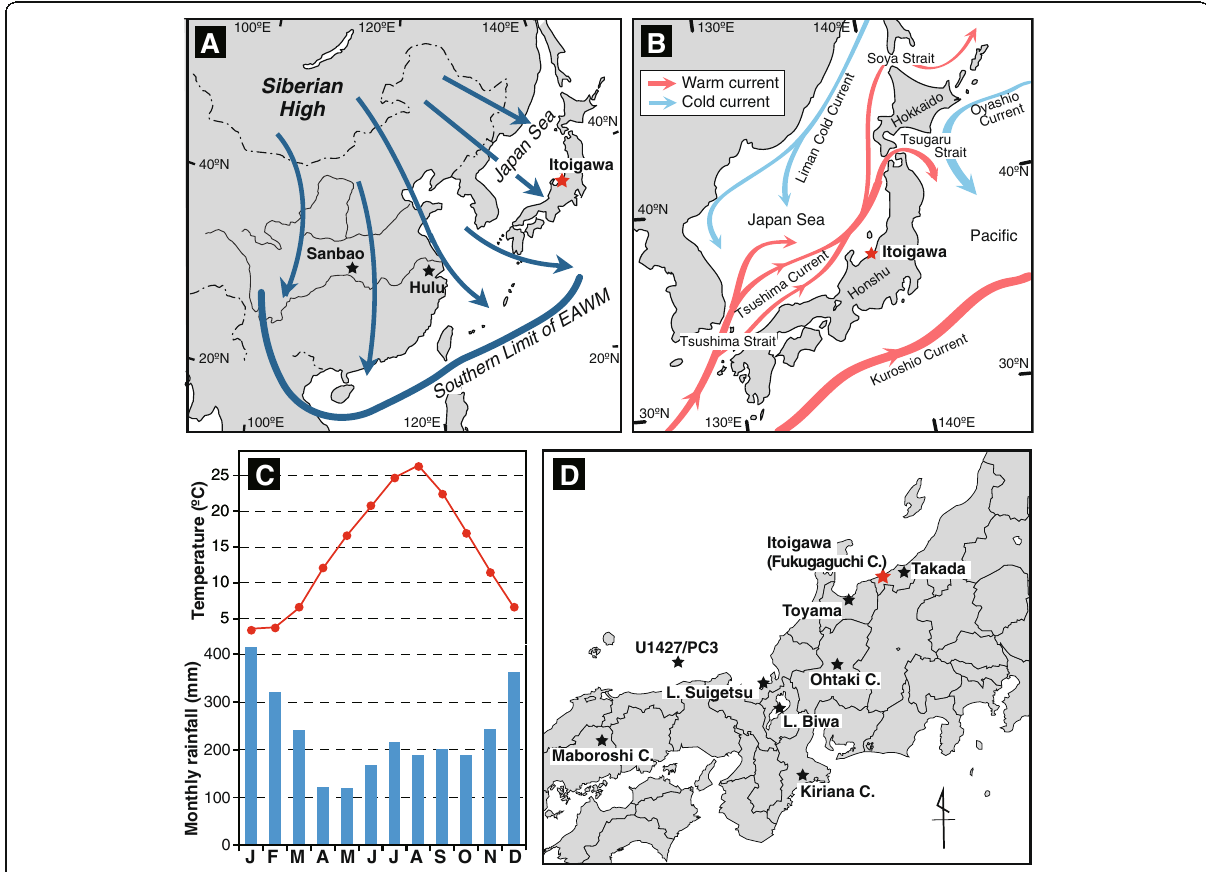
Fig. 1 Geographic and climatological setting of the study site, Itoigawa. a Map showing the general wind directions in the winter, the southern limit of the EAWM, and the locations of the Itoigawa and Chinese caves. b Warm and cold currents around Japan. The Tsushima Warm Current enters the Japan Sea through the Tsushima strait and outflows to the Northwestern Pacific Ocean through the Tsugaru and Soya straits. c Monthly mean temperature (°C) at Itoigawa (upper) and rainfall (mm) at the Hiraiwa Precipitation Observatory (lower) during the period 1990 – 2009. d Locations of caves (Maboroshi, Ohtaki, and Kiriana), lakes (Suigetsu and Biwa), a coring site (U1427/PC3), and observatory sites (Toyama and Takada) discussed in this